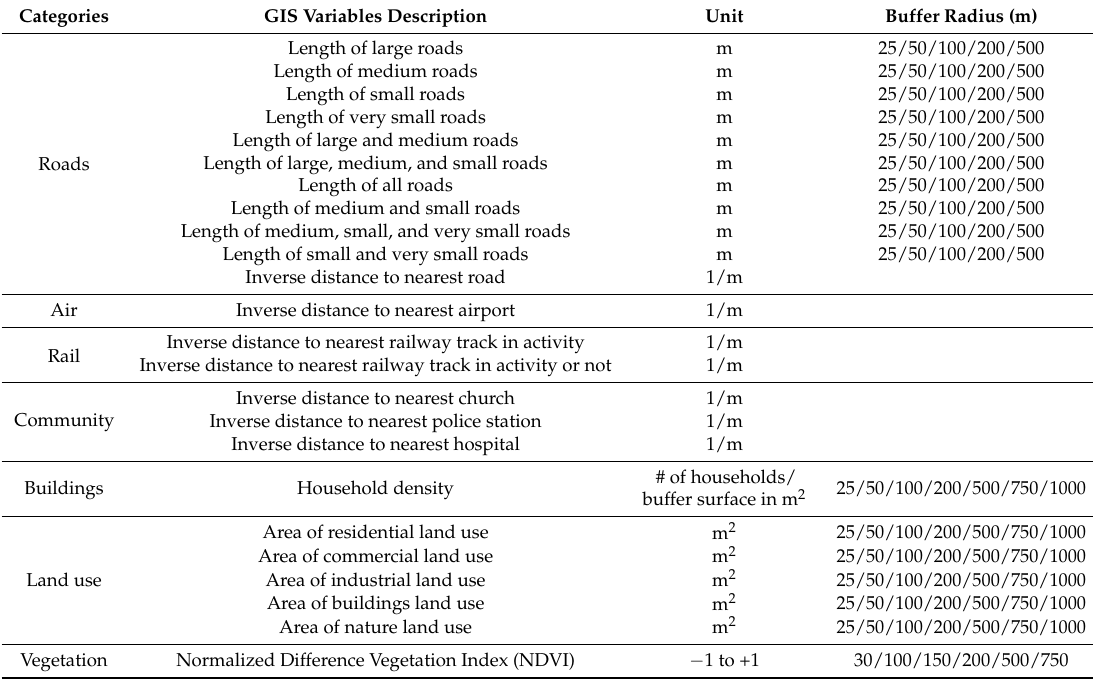
Table 1. List of geographic information system (GIS) variables potentially influencing noise